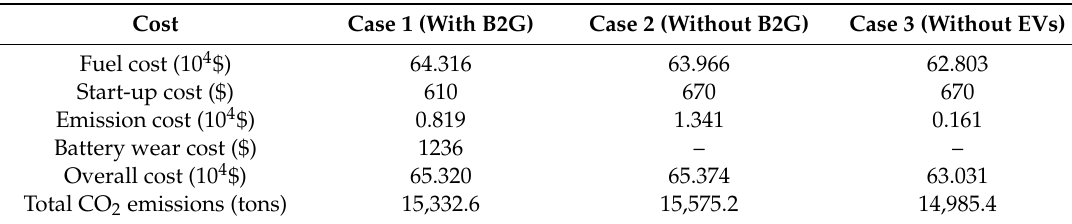
Table 3. Costs and CO 2 Emissions in Different